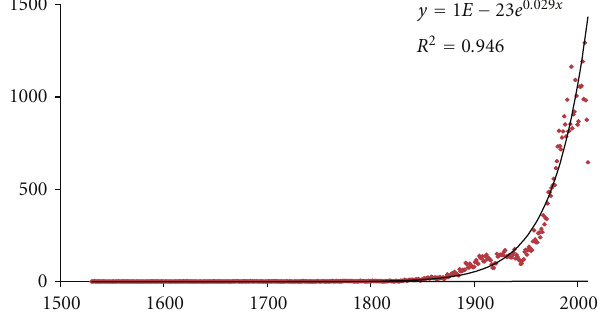
Figure 2: The exponential spread of World ant literature ( n = 46,182). The regression is based on annual production and is calculated for the period between 1800 and 2010. An extrapolation estimates to 1,700 for the number of projected papers on ant biology for 2020. Formis 2011